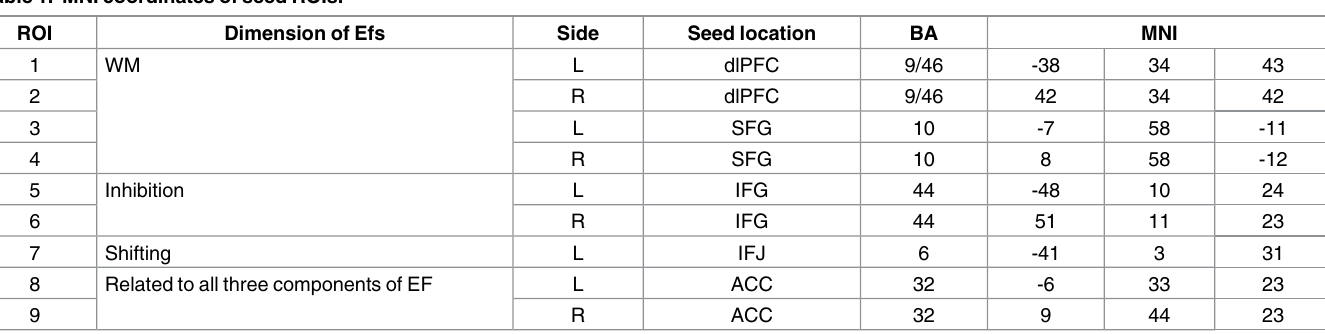
Table 1. MNI coordinates of seed ROIs.